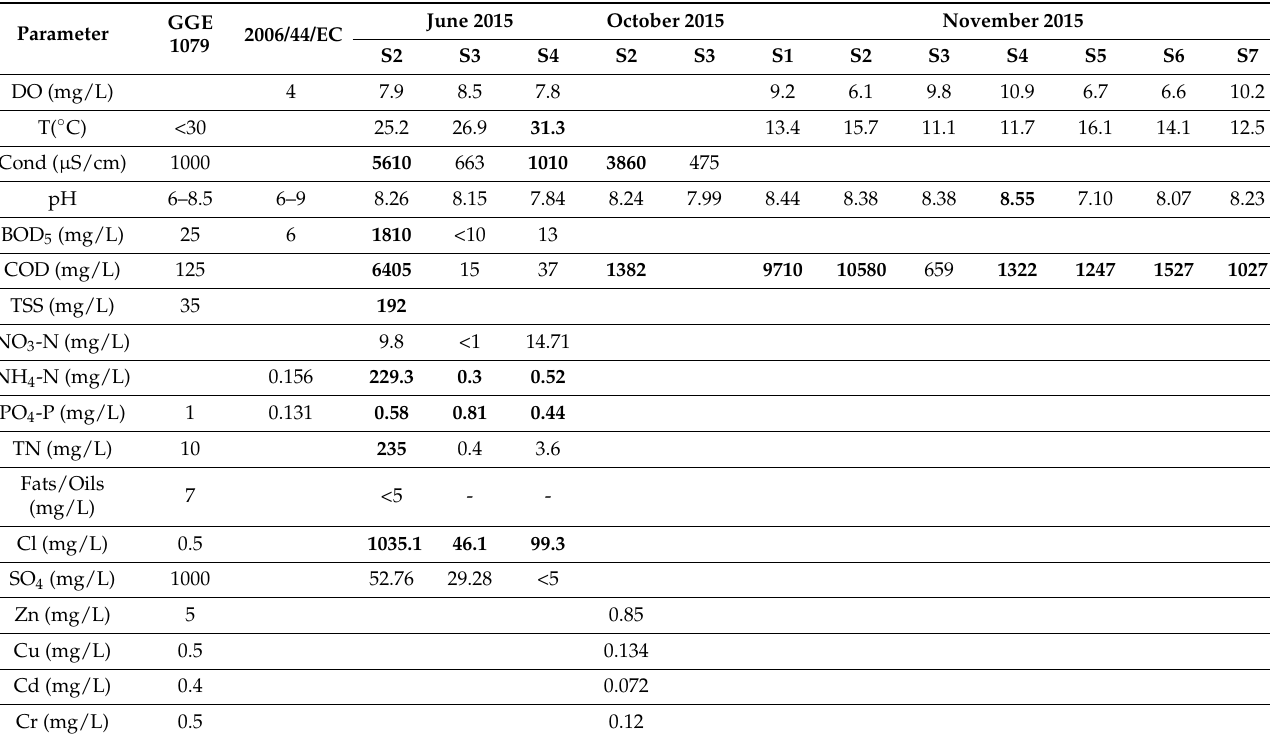
Table 2. Physicochemical parameters measured in water samples of Bogdanas River. With bold the values that exceed limits. Government Gazette (GGE) 1079: [35], Directive 2006/44/EC: [36].